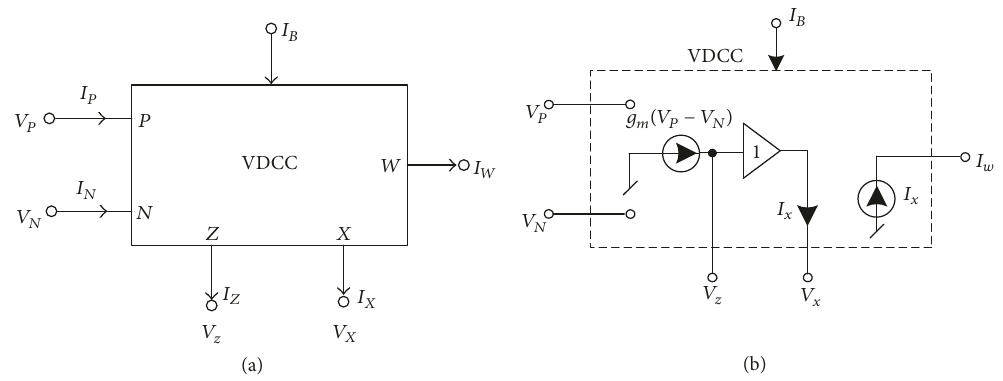
Figure 1: VDCC: (a) circuit symbol of VDCC; (b) equivalent